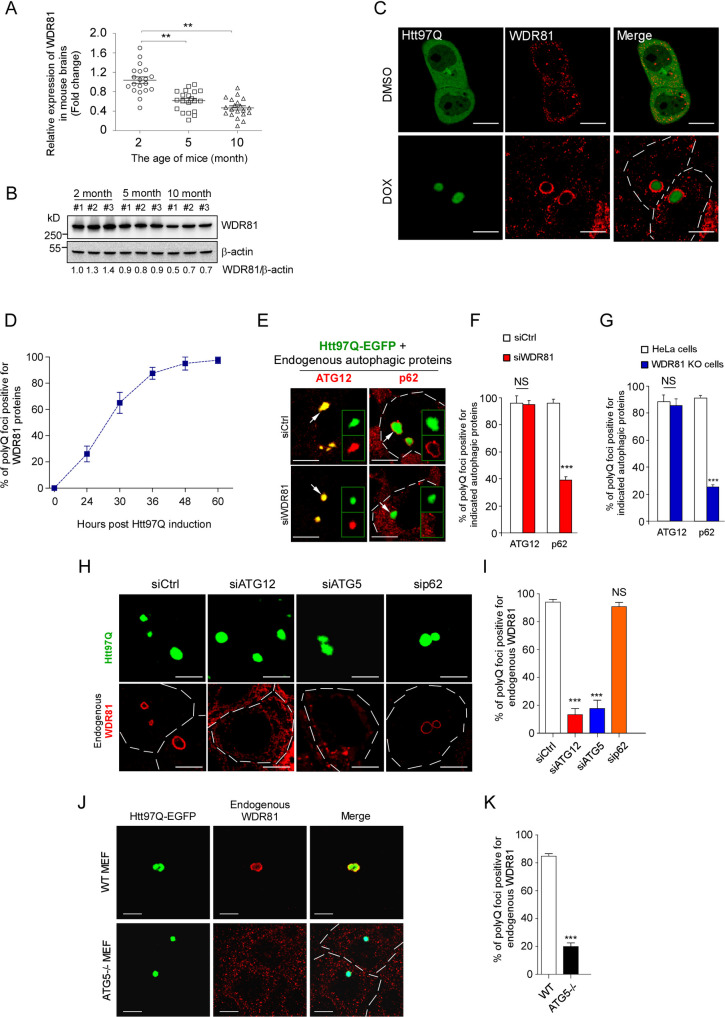
WDR81 facilitates the recruitment of p62 onto Htt97Q-EGFP aggregates.mRNA level of WDR81 was decreased in the brains of male wild-type mice with the growth of age (n = 20 in each group). Protein level of WDR81 was decreased in the brains of male wild-type mice with the growth of age (n = 3 in each group). (C and D) DOX-induced Htt97Q-EGFP aggregates recruited endogenous WDR81 in HeLa cells (C). After doxycycline (DOX, 1 μg/ml) treatment, HeLa cells stably expressed Tet-on Htt97Q-EGFP. Time-course analysis of WDR81 recruitment onto Htt97Q-EGFP aggregates (D). 200 cells were analyzed for the recruitment. White dotted lines are the outlines of cells. (E and F) Recruitment of endogenous autophagic proteins onto Htt97Q-EGFP aggregates after knockdown of WDR81. Insets show the signals from Htt97Q-EGFP (green) and endogenous autophagic proteins (red) in the aggregates indicated by the white arrows in the main images (left panel). Statistical analysis of the percentage of polyQ foci positive for each indicated autophagic protein (right panel). 220 cells were analyzed for the colocalization in each group. (G) Statistical analysis of the percentage of polyQ foci positive for each indicated autophagic protein in WDR81 KO cells. 210 cells were analyzed for the colocalization in each group. (H and I) Recruitment of endogenous WDR81 onto Htt97Q-EGFP aggregates after knockdown of indicated autophagic proteins. HeLa cells stably expressing Htt97Q-EGFP were transfected twice at an interval of 24 h with siRNAs for indicated autophagic proteins. 12 h after the second siRNA transfection, DOX was administrated into medium to induce Htt97Q-EGFP expression (left panel). Statistical analysis of the percentage of polyQ foci positive for endogenous WDR81 (right panel). 240 cells were analyzed for the colocalization in each group. (J and K) Recruitment of endogenous WDR81 onto Htt97Q-EGFP aggregates in WT or ATG5-/- MEFs. For quantifications, means±SEM were derived from three independent experiments and analyzed using t-test or ANOVA. ** P <0.01. *** P <0.001. NS, not significant.